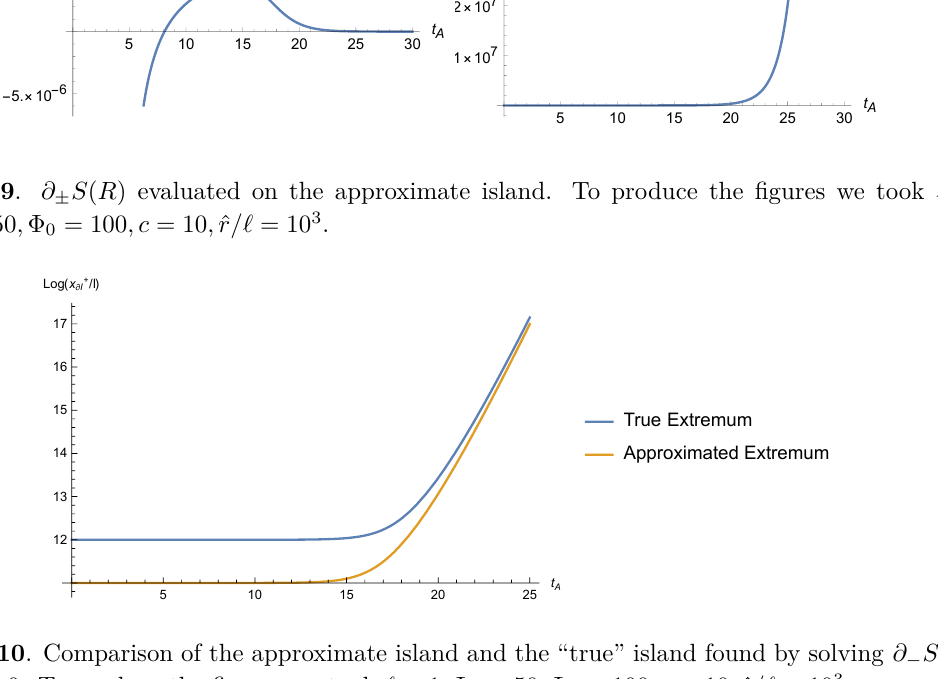
‘/c both solutions converge, see figure 10, s